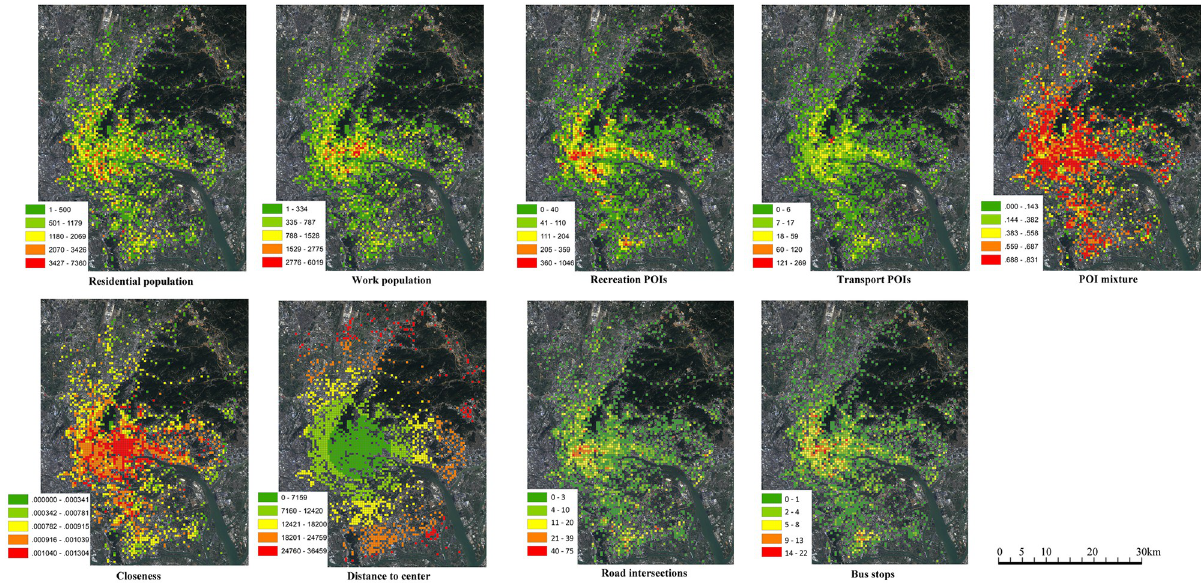
Fig 3. Spatial distributions of built environment